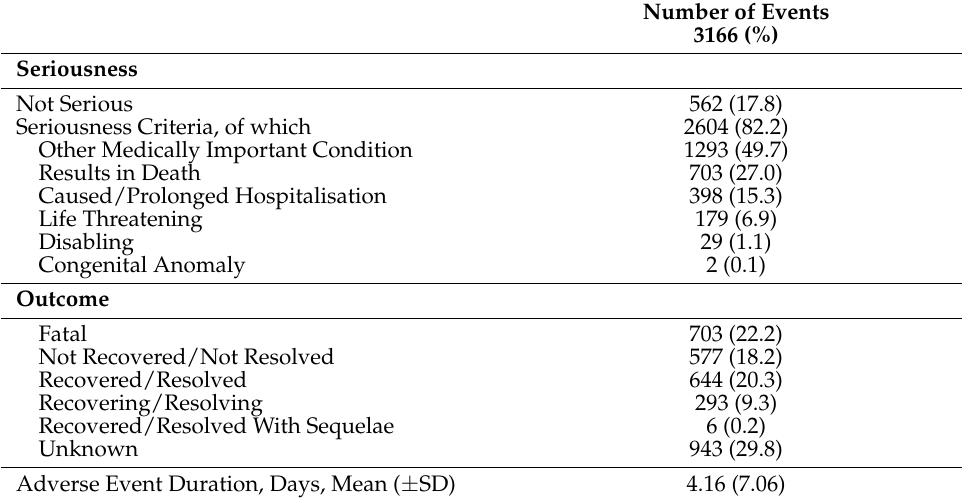
Table 2. Characteristics of adverse